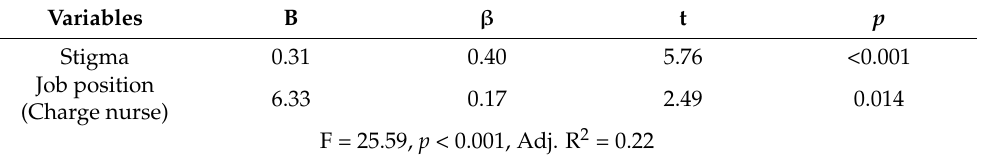
Table 5. Factors influencing stress ( n =